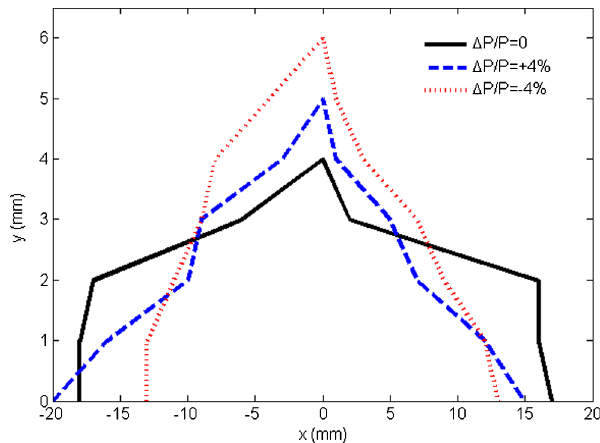
FIG. 16. On axis brilliance of the synchrotron radiation in the ILSF first user phase of operation.